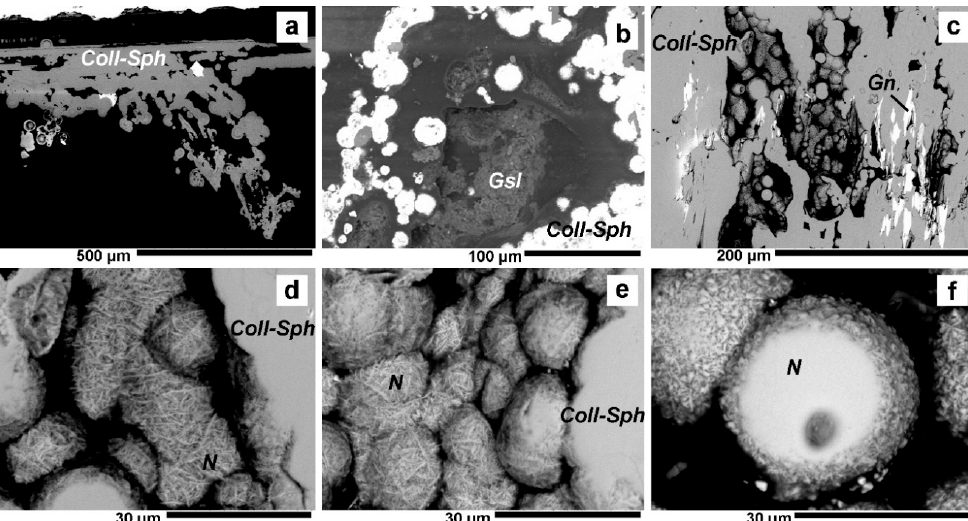
Figure 7. BSE images obtained using the backscatter electron detector equipped with the Hitachi Tabletop TM3030: ( a,b ) nodules of colloform sphalerite (Coll-Sph) associated with goslarite (Gsl); ( c ) porous masses with galena (Gn) inclusions; ( d,e ) nodular nano/microscale clusters of colloform sphalerite; ( f ) polished nodules of colloform sphalerite (N).